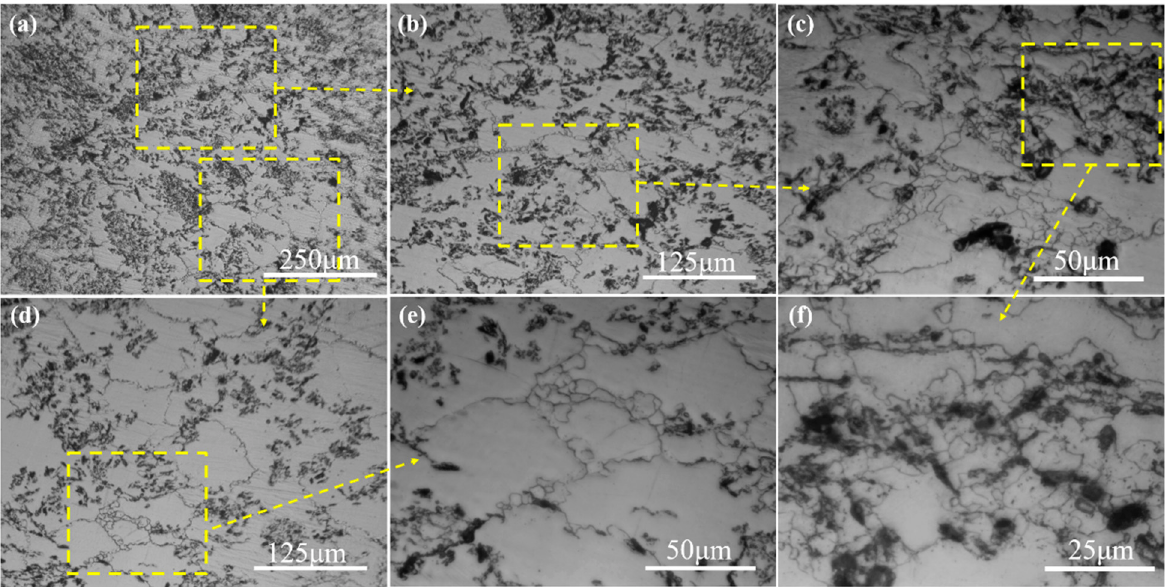
Figure 6. OM microstructure of the SiC p /Mg-5Zn material with a compression strain of 0.1: ( a , b , d ) low magnification and ( c , e , f ) high magnification.